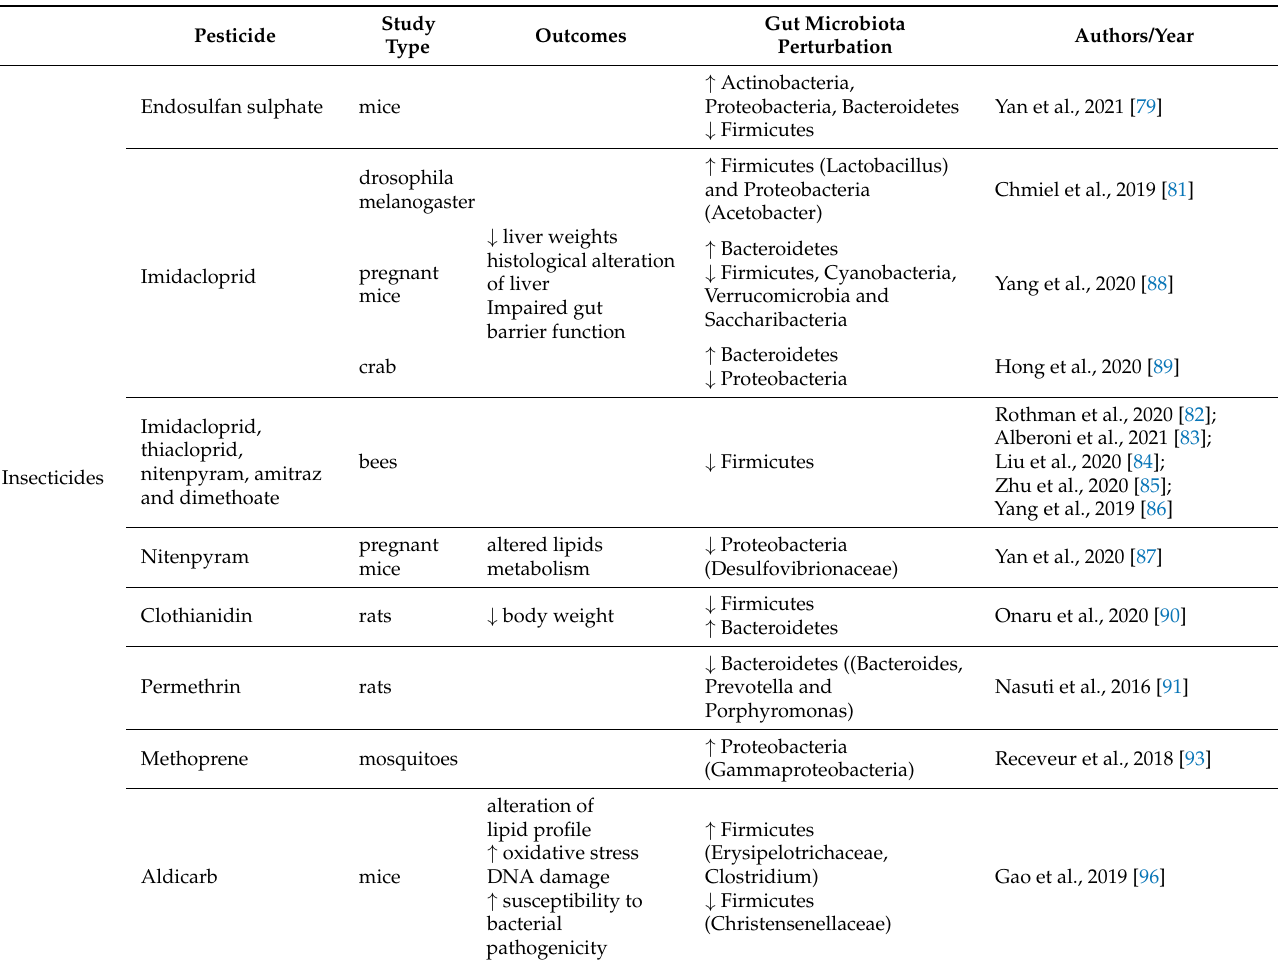
Table A4. Current literature on gut microbiota perturbation due to exposure to